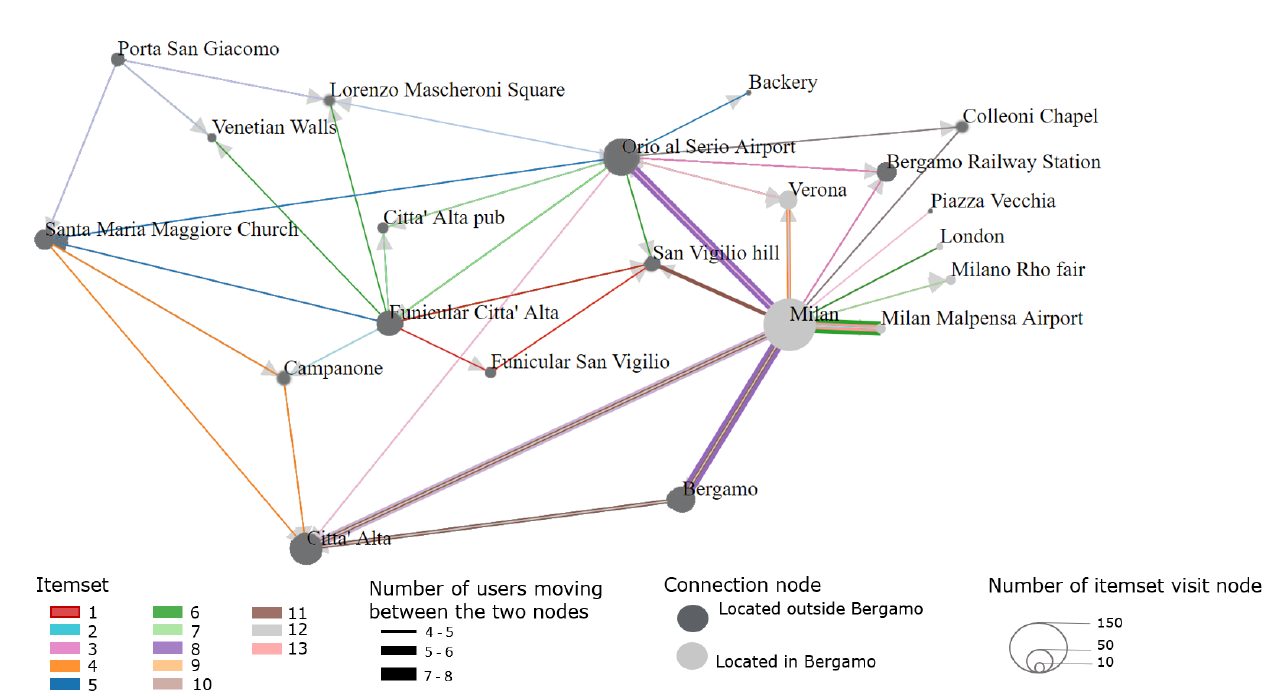
Figure 9. Topographic representation for discovered itemsets associating indirect transfers (Interpretation 3), focused at the level of the Bergamo area.